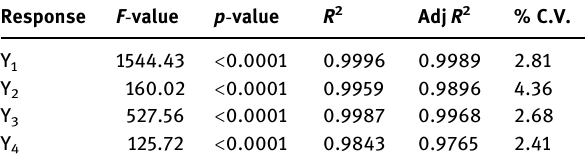
Table 4: Summary of ANOVA for the response parameters of the model formulations of bilayer tablets prepared as per D - optimal mixture design